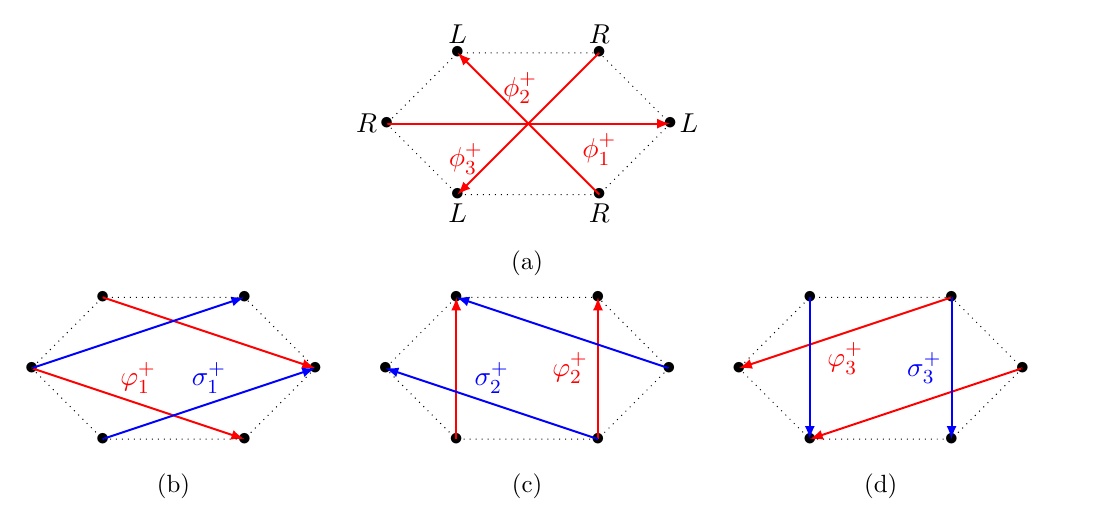
Figure 16. Regular zero modes of rank 1 or 2 for C [(1 ; 1)] brane. The maximal Higgs (cid:30) +